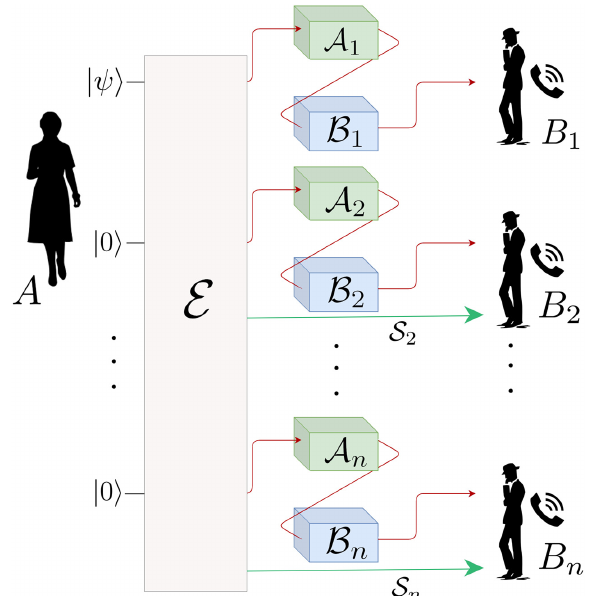
FIG. 3. Random-receiver quantum communication with k < n noiseless side channels. Alice communicates to the n receivers through entanglement-breaking channels in a fixed order, with the assistance of k < n noiseless qubit channels, transferring quantum information from her lab to the labs of the k